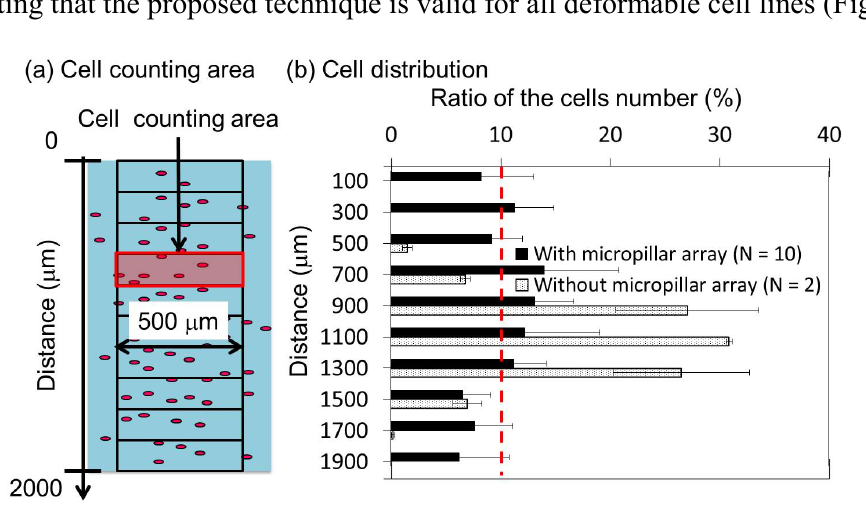
Figure 14. Cell distribution in microchamber without/with the micropillar